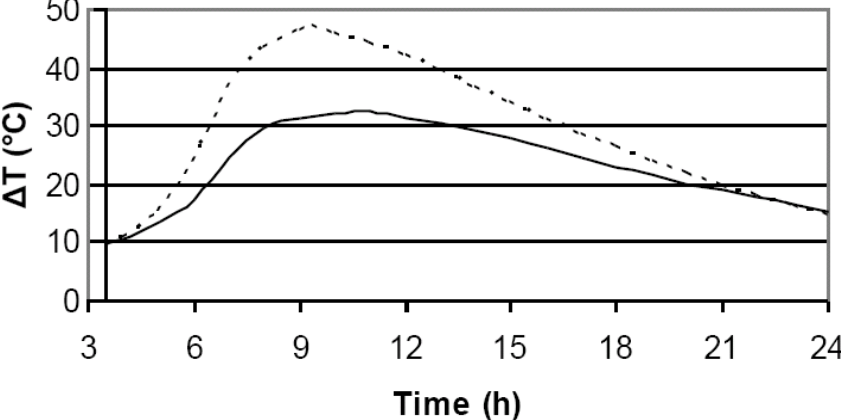
Figure 3. Hydration temperature for neat cement and wood-cement mixture. Values represent differences between the actual readings and the room